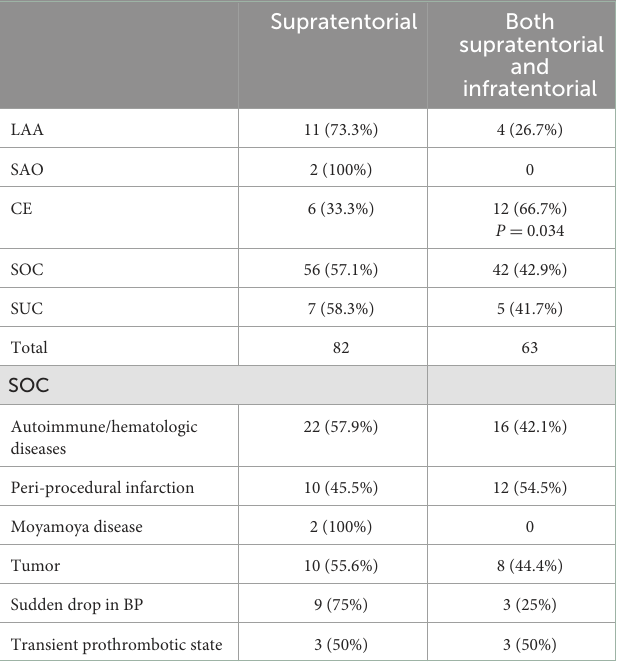
TABLE 3 Detailed lesion distribution patterns of AMIMCT with distinct